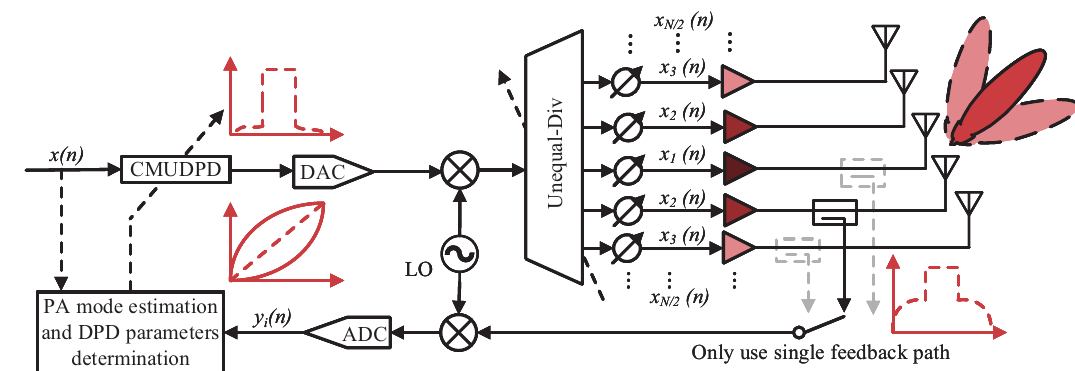
Figure 2. The system architecture of non-uniform amplitude excitation arrays with the proposed CMUDPD linearization